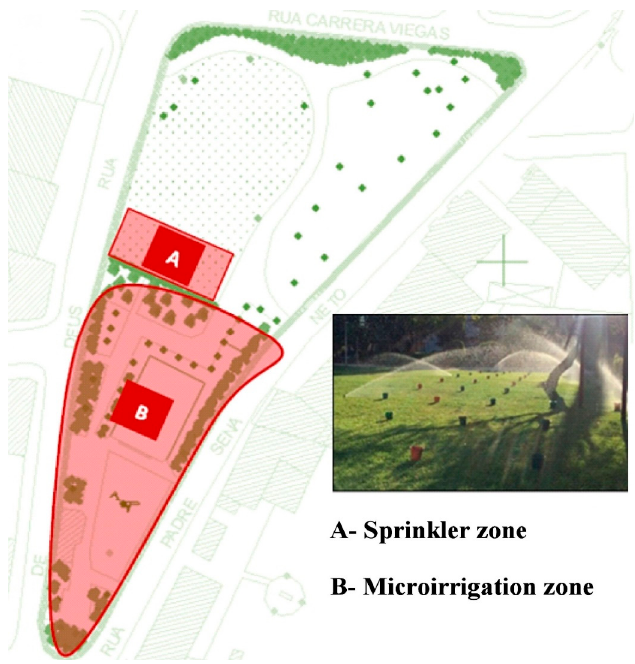
Figure 3. Urban green area number 30 and its irrigation systems.